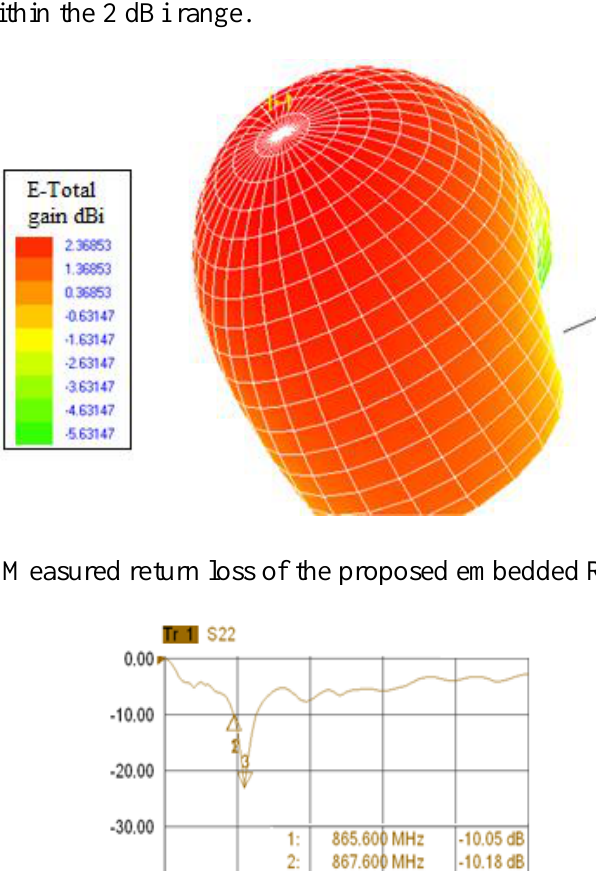
Figure 6. The radiation pattern of the proposed embedded RFID antenna, E-Total, showing simulated gains, within the 2 dBi range.